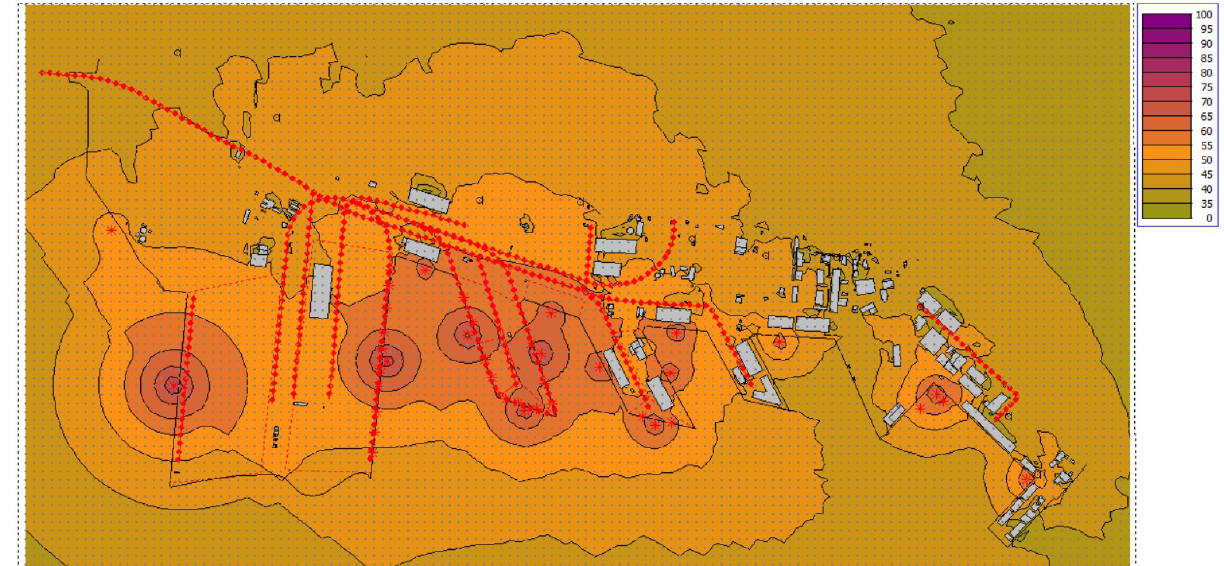
Figure 8: Noise map of the Port of Thessaloniki for the worst-case wind conditions (Lnight)